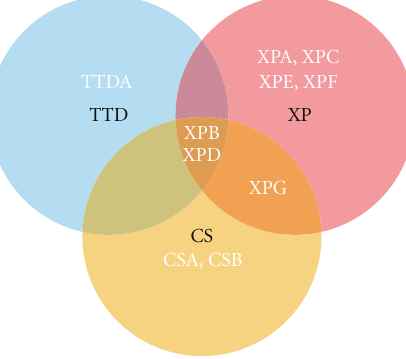
Figure 1: Three disorders for nine genes. Mutations in ten genes are responsible for the xeroderma pigmentosum (XP), the trichothyodystrophy (TTD) or the Cockayne syndrome (CS). XPA, XPC, XPE and XPF are only involved in XP; CSA and CSB are only involved in CS; XPG is involved in pure XP or in an combined XP/CS syndrome; XPB and XPD are involved in TTD, XP, or in a combined XP/CS syndrome. TTDA is only involved in